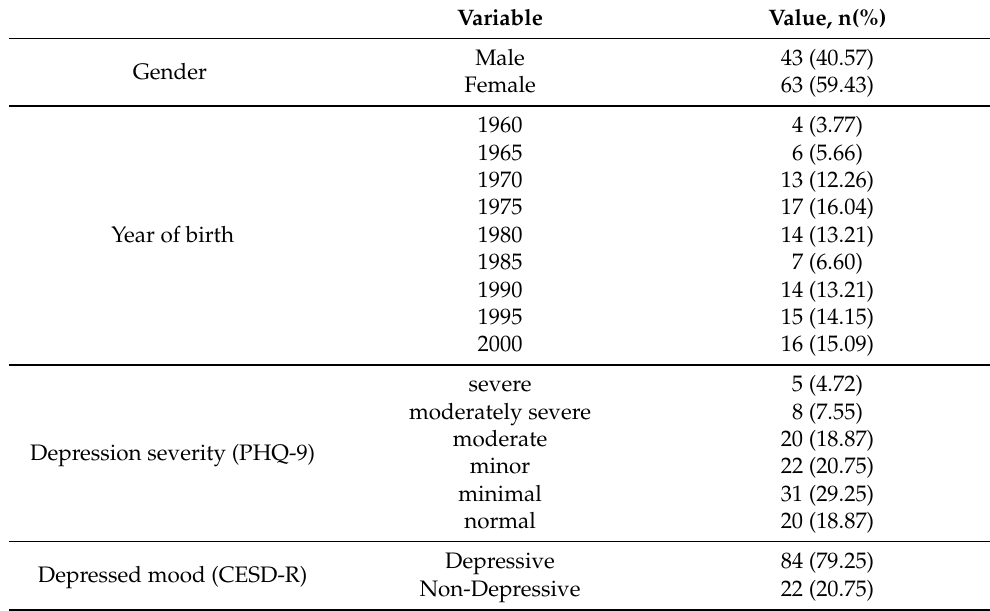
responses to self-report questionnaires for the participants. Statistics for participants on “age”, “gender”, “depression severity for response scores”, and “depressed mood by cut-point” are